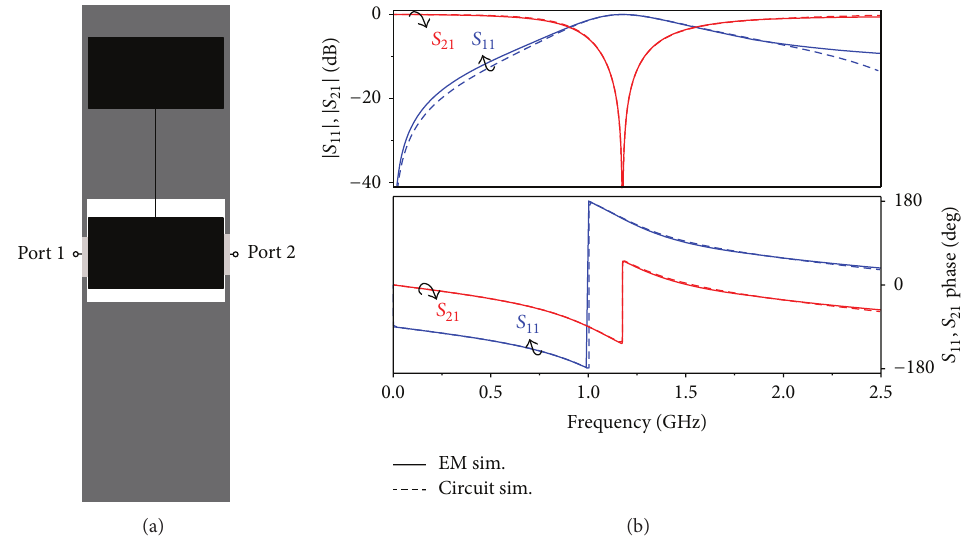
Figure 5: Topology of an electrically small SIR loaded microstrip line (a) and transmission/reflection coefficients from the lossless electromagnetic and circuit simulations (b). The structure is the same as that of Figure 4(a) with the exception of the SIR length, with the lengths of the wide and narrow sections being, respectively, 4 mm and 6 mm. The lumped element values are 𝐿 = 4.43 nH, 𝐶 = 1.58 pF, = 6.90 , and 𝐶 = 2.66 pF. 𝐿 𝑠 𝑠